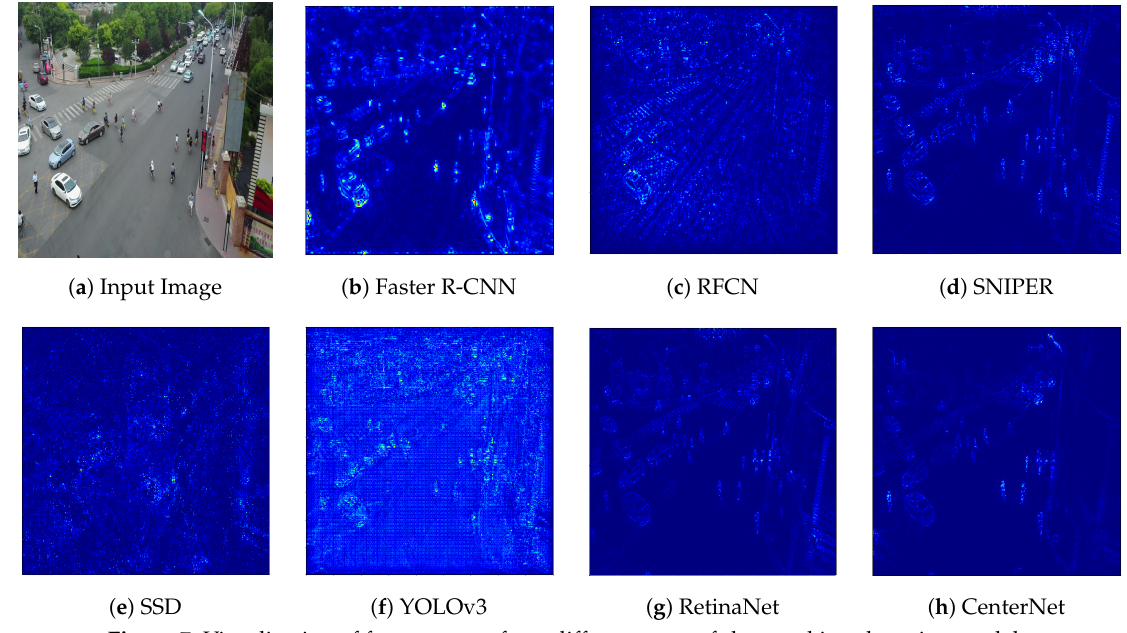
Figure 7. Visualization of feature maps from different state-of-the-art object detection